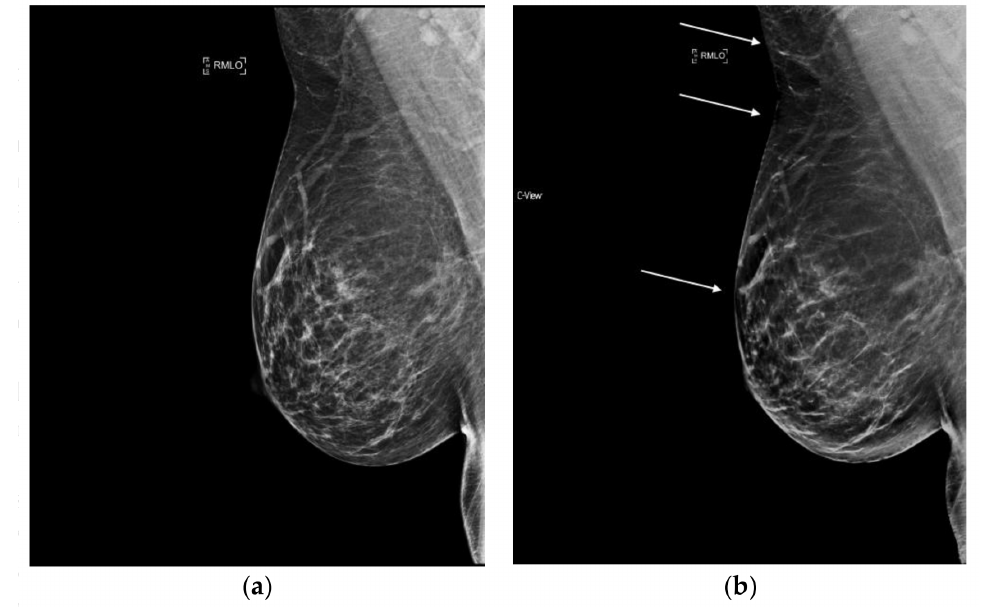
Figure 7. Loss of skin resolution or “skin burnout” (indicated by arrows) can be seen on synthesized mammography. ( a ) 2D FFDM (no artifact) ( b ) s2D with skin burnout